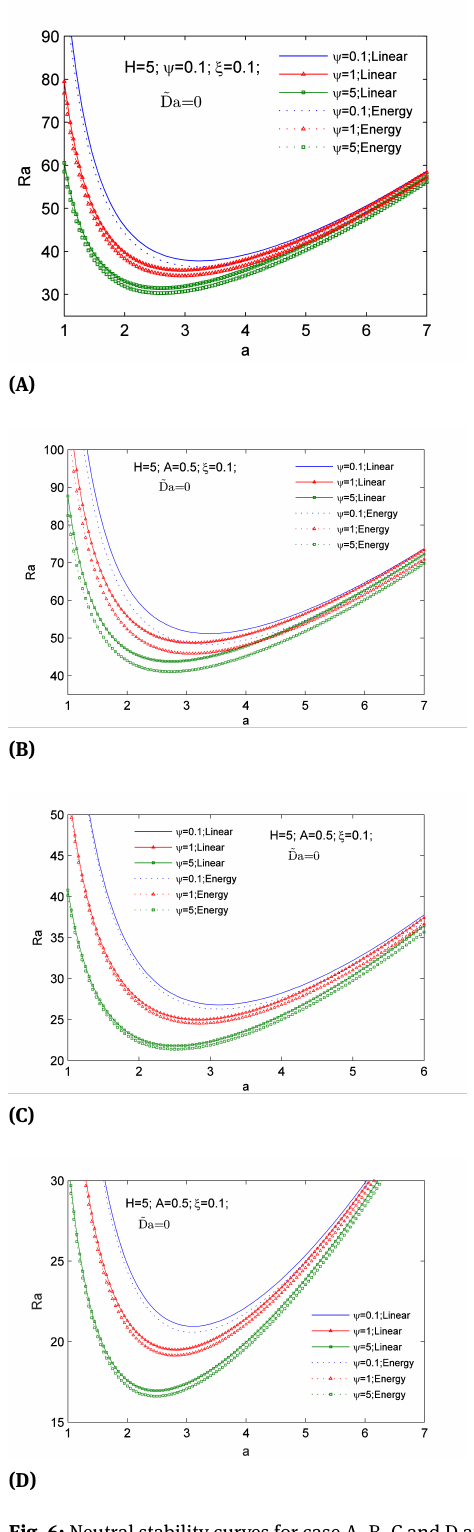
Fig. 6: Neutral stability curves for case A, B, C and D at different values of ψ and fixed values of H , ξ , ˜ Da ,